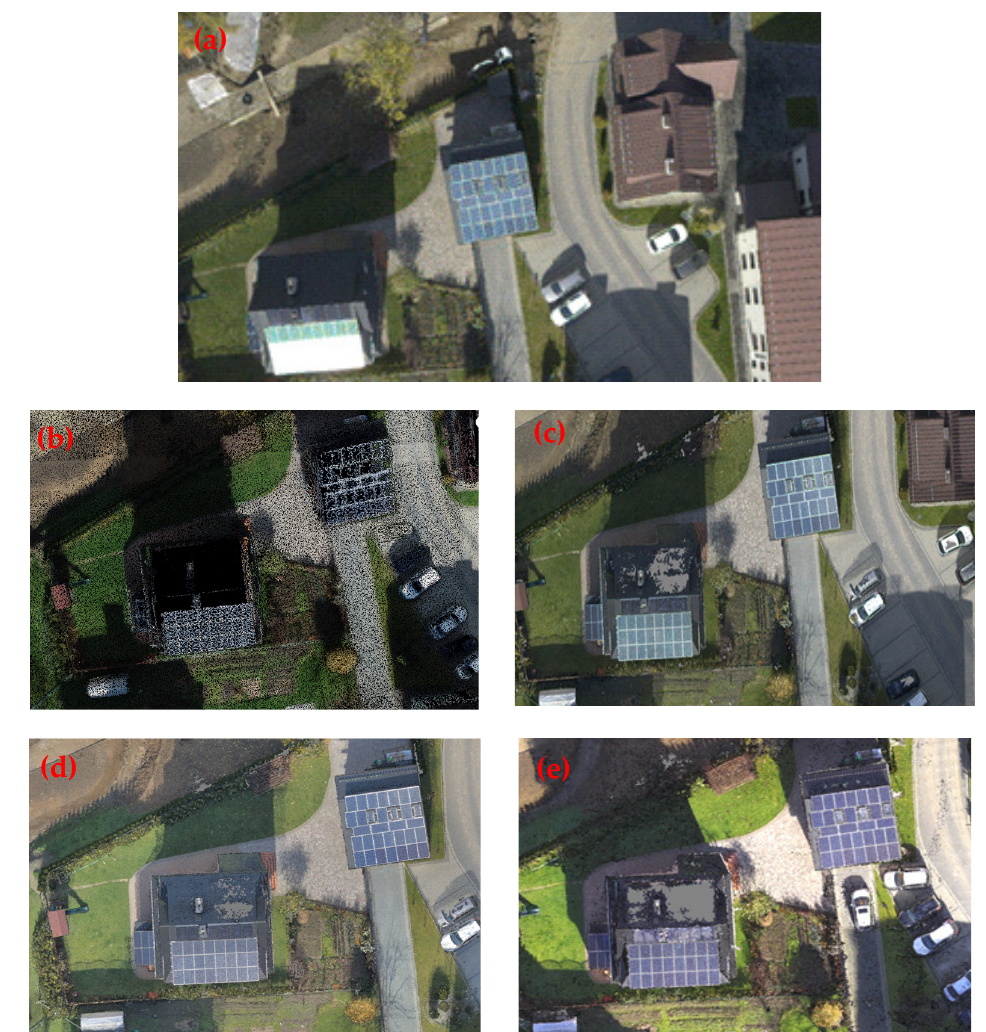
Figure 8. Missing information for roof planes in point clouds example 2 ( a ) photos of roof planes ( b ) point cloud from L1 scanner, ( c ) point cloud from DNG files, P1 camera, ( d ) point cloud from TIF files, P1 camera, ( e ) point cloud from JPG files PSDK camera.